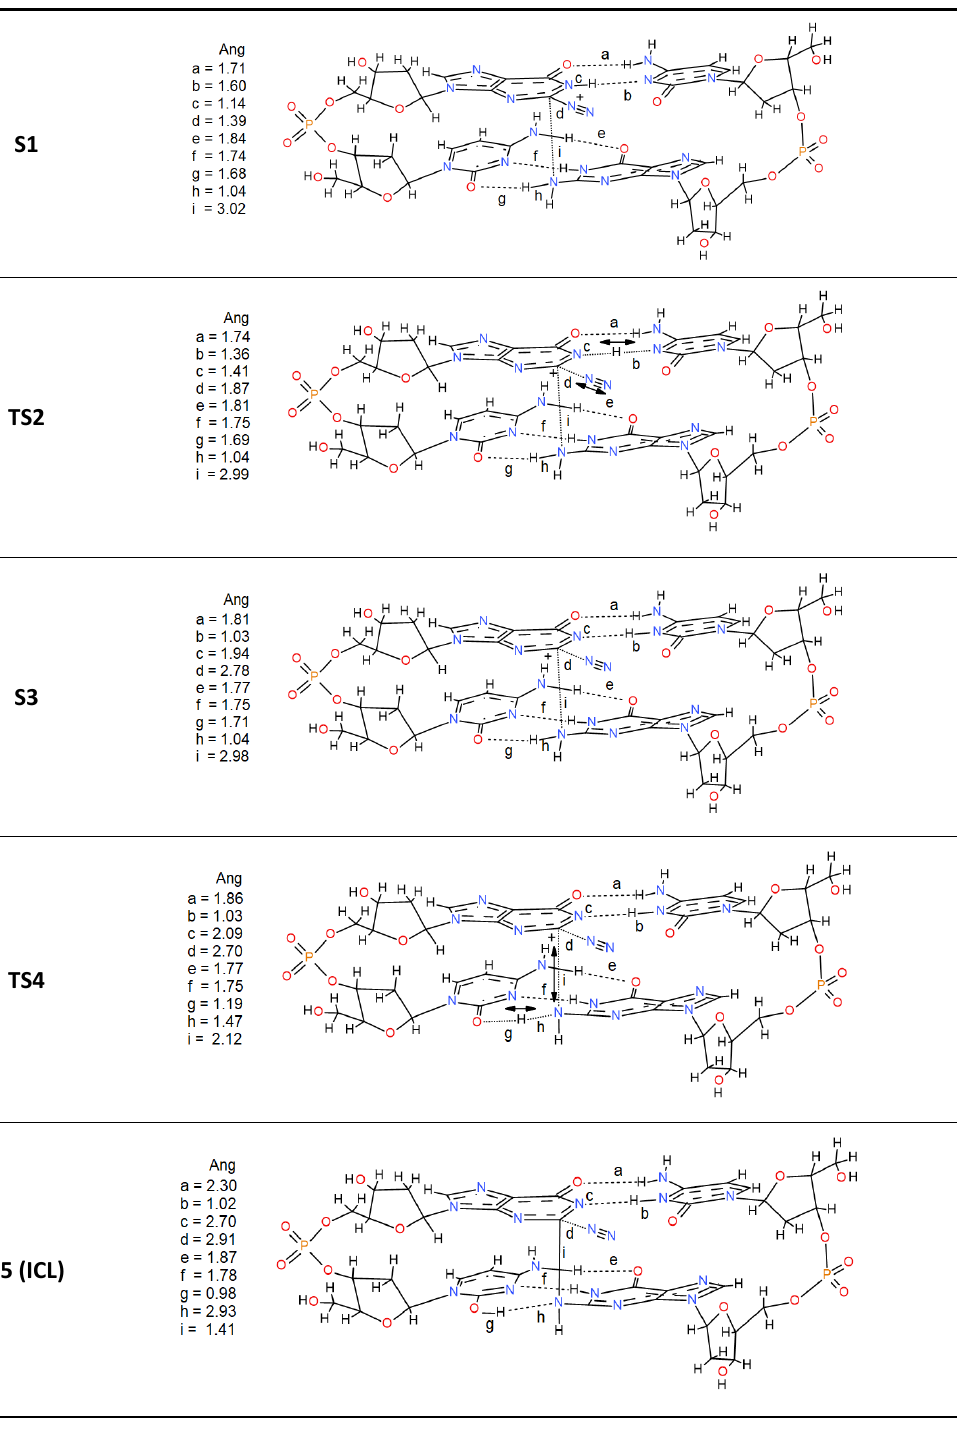
Scheme 1. Mechanism of formation of Guanine-Guanine ICL (S5) from the diazonium adduct